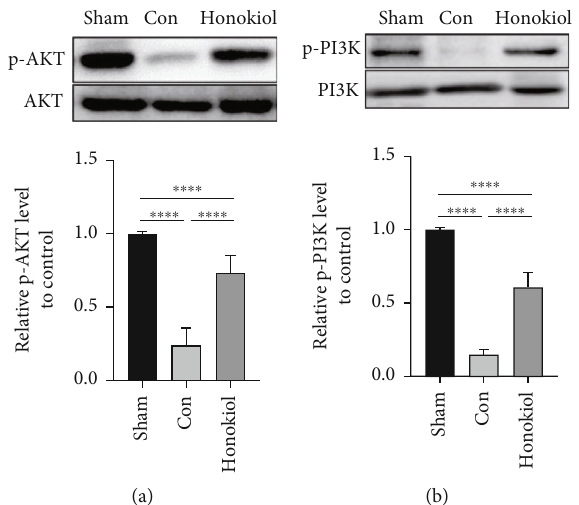
Figure 7: Western blot analysis of PI3K/AKT pathway-related proteins. (a) AKT and (b) PI3K were identi fi ed through WB. Sham: sham operation; Con: MI/RI with vehicle; Honokiol: MI/RI with Honokiol. N = 6 for each cohort. Data are articulated as mean ± SEM . ∗∗∗ ∗ p < 0 : 0001